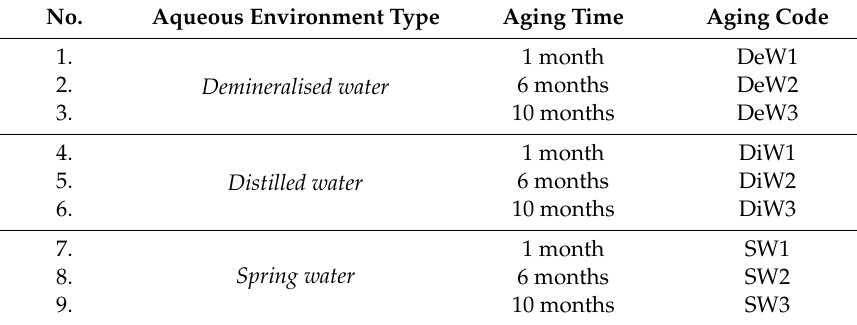
Table 5. Aging conditions.